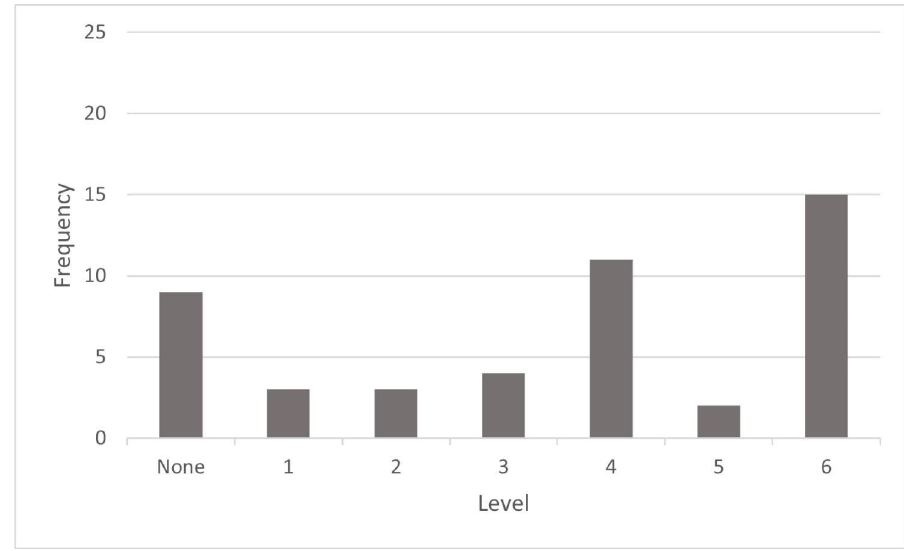
Fig. 2 Frequency Distribution of Firms According to 2018 CSR